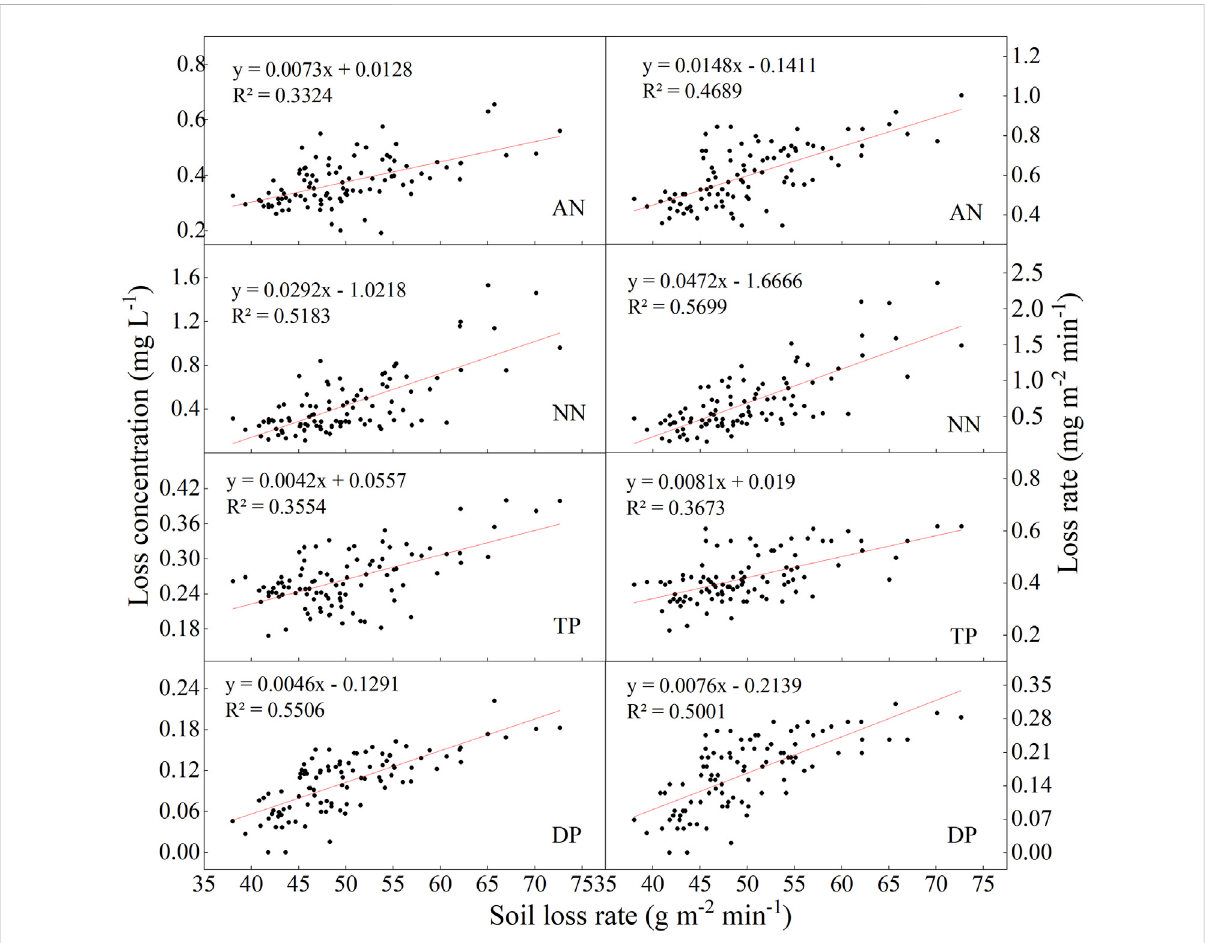
FIGURE 5 Correlation between soil loss and nutrient loss under the freeze-thaw conditions after 5 min rainfall duration. AN, ammonia nitrogen; NN, nitrate nitrogen; TP, total phosphorus; DP, dissolved phosphorus.